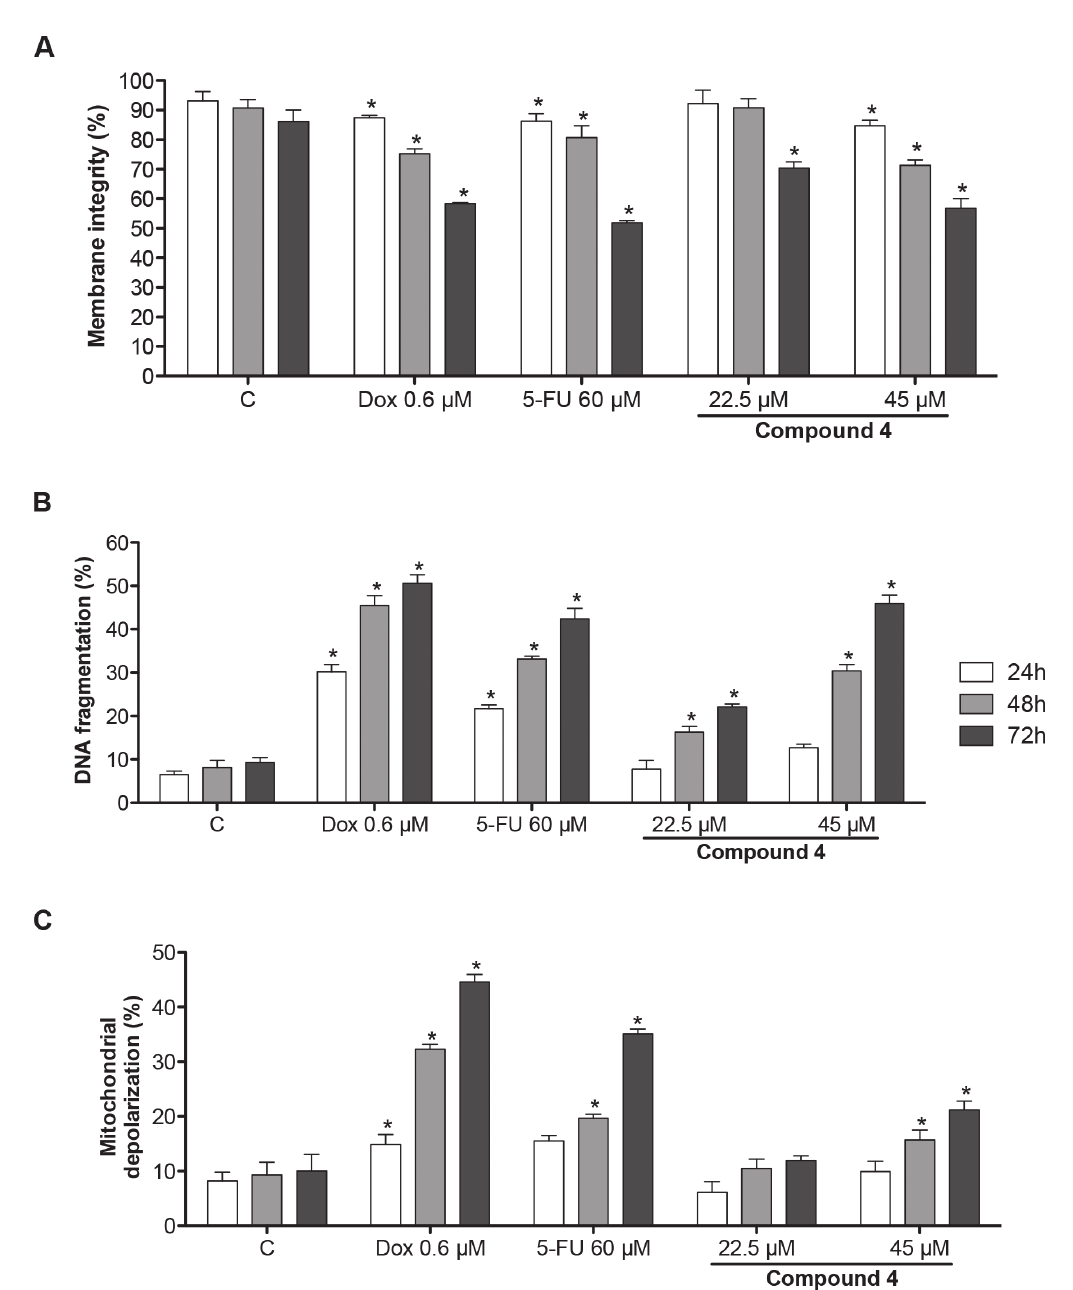
Figure 2 - Flow cytometry analysis of the N -phthaloyl derivative effects on primary culture of Sarcoma 180 cells after 24, 48 and 72 h of incubation. A – Membrane integrity determined by exclusion of propidium iodide (50 μg/mL); B – Internucleosomal DNA fragmentation evaluated by nuclear fluorescence using citrate, Triton X-100 and 50 μg/ mL propidium iodide; C – Mitochondrial depolarization quantified using rhodamine 123. Negative control (C) was treated with the vehicle used for diluting the tested substance. Doxorubicin (Dox, 0.6 µM) and 5-Fluorouracil (5-FU, 60 µM) were used as positive controls. Results are expressed as mean ± standard error of measurement (S.E.M) from three independent experiments. * P < 0.05 compared to control by ANOVA followed by Student Newman-Keuls